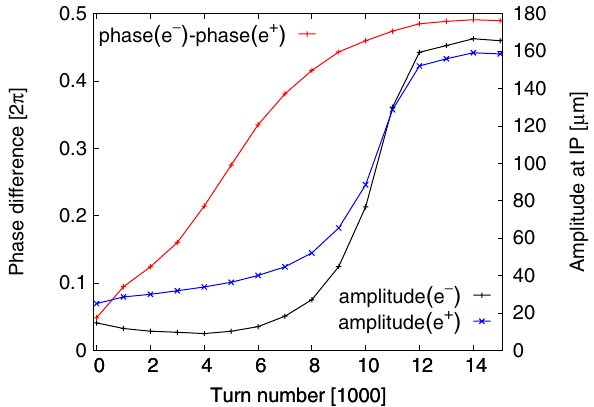
FIG. 8. Simulated time evolution of the driven spectral lines of the horizontal motion of the electron and the positron beams for an unstable case (CC noise at IP is 5 (cid:3) m with frequency 0.523). The phase difference between the driven spectral lines of the two beams is shown versus turn number. The amplitudes of the e (cid:2) and e þ motion at the same frequency are also shown.